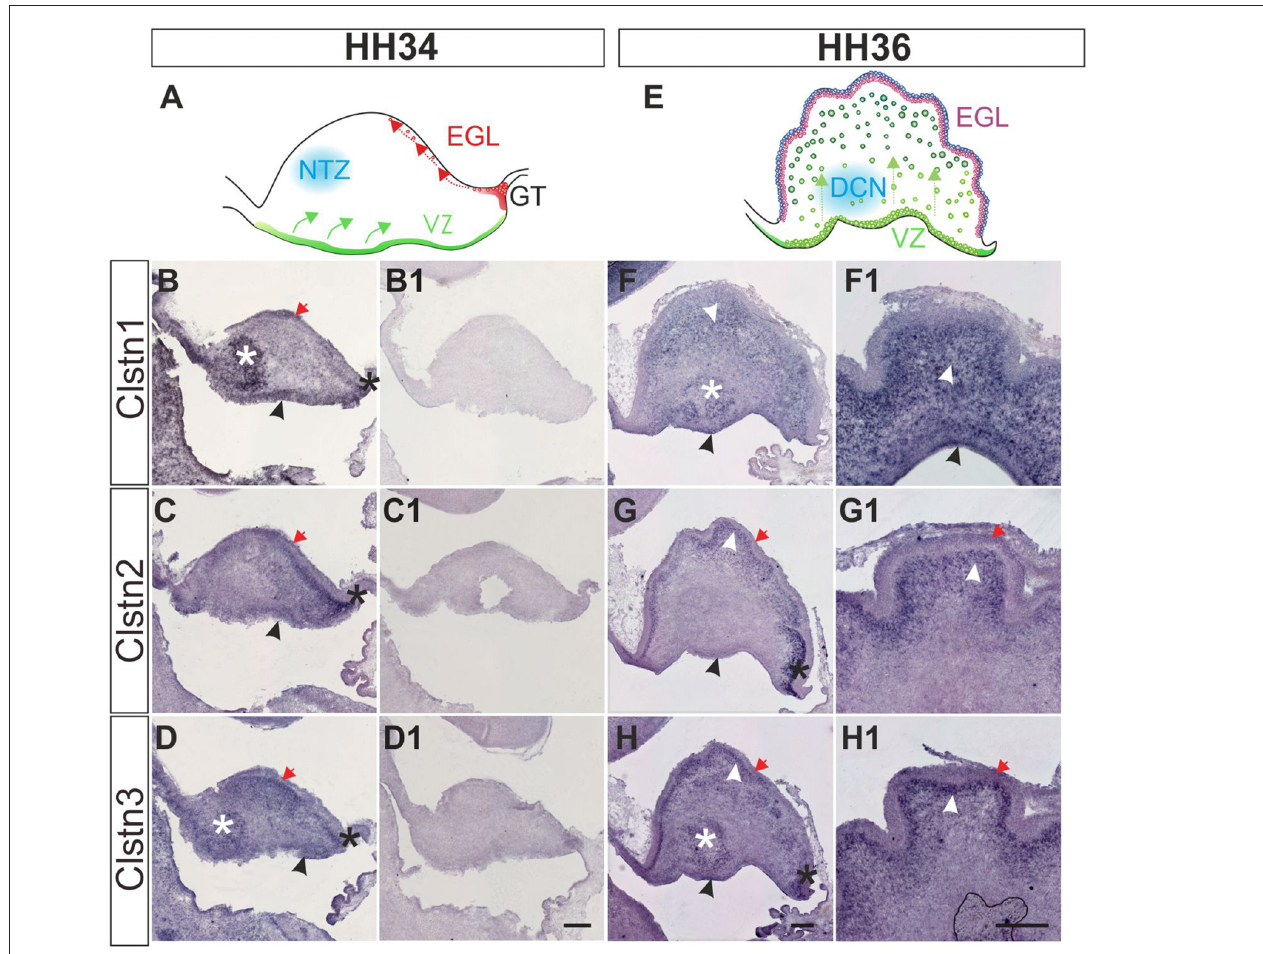
FIGURE 6 | Calsyntenins are expressed in early stages of cerebellar development. Cerebellar development can be analyzed in chicken embryos as early as HH34 (A) . In the VZ Purkinje cells are born and migrate away from the ventricle (green). First restricted to the caudal part of the cerebellar anlage, granule cell precursors migrate tangentially to form the external granule cell layer (EGL; red). The blue area outlines cells in the nuclear transitory zone (NTZ; blue; Altman and Bayer, 1997). At this early stage all calsyntenins are expressed in the cerebellar anlage. Clstn1 (B) is expressed in the VZ (black arrowhead), the developing EGL (red arrow), in the germinal trigone (black asterisk) and in the NTZ (white asterisk). Clstn2 (C) is expressed in the VZ (black arrowhead) and in the developing EGL (red arrow), as well as in the germinal trigone (black asterisk). Expression of Clstn3 (D) is similar to Clstn1. It is detected in the VZ (black arrowhead), the developing EGL (red arrow), in the germinal trigone (black asterisk) and in the NTZ (white asterisk). (B1–D1) are adjacent sections to those shown in (B–D) but processed with the respective sense probes. At HH36 (E) , foliation starts because granule cell proliferation in the EGL is rapidly expanding cell numbers. Purkinje cells are still migrating toward the EGL (green). The precursors of the deep cerebellar nuclei (DCN) have descended and are clearly visible in sections taken from the lateral part of the cerebellum. Shown in (F–H) are sections taken from the lateral part of a HH36 cerebellum. Those shown in (F1–H1) are taken from a medial position of the same cerebellum. At HH36, Clstn1 (F,F1) is expressed in ascending Purkinje cells (white arrowhead) and in cells of the DCN (white asterisk), as well as in the VZ (black arrowhead). Clstn2 (G,G1) is not found in the central parts of the cerebellar anlage, but high levels of expression are still seen in the germinal trigone (black asterisk) and the granule cell precursors in the EGL (red arrow). It is expressed in Purkinje cells in the developing folds (white arrowhead) and weakly in the VZ (black arrowhead). Clstn3 expression is also similar to Clstn1 at this stage. Clstn3 mRNA is found in the EGL (red arrow), in the germinal trigone (black asterisk), in the VZ (black arrowhead) and in DCN (white asterisk) (H,H1) . Bar: 200 µ